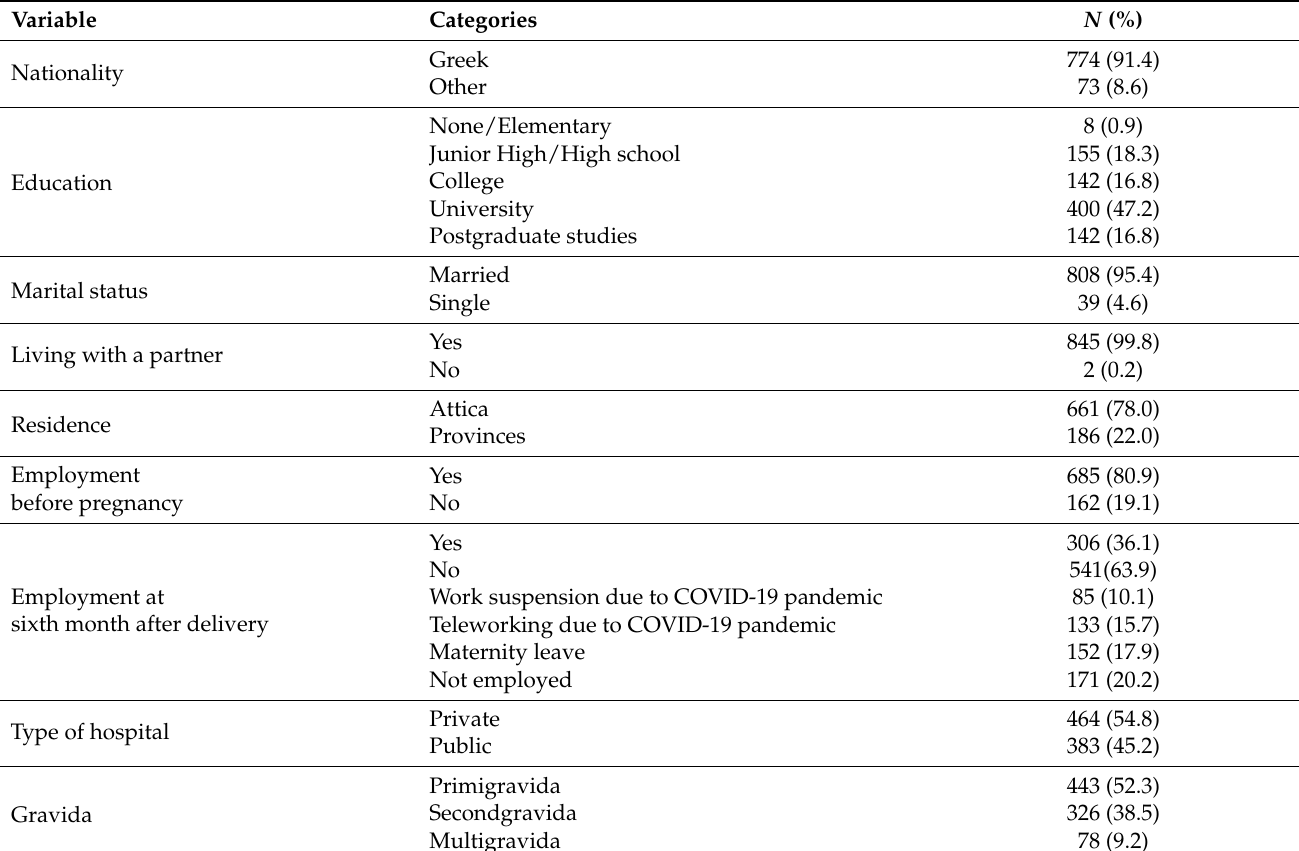
Table 1. Maternal baseline sociodemographic characteristics and history related to pregnancy and birth (qualitative